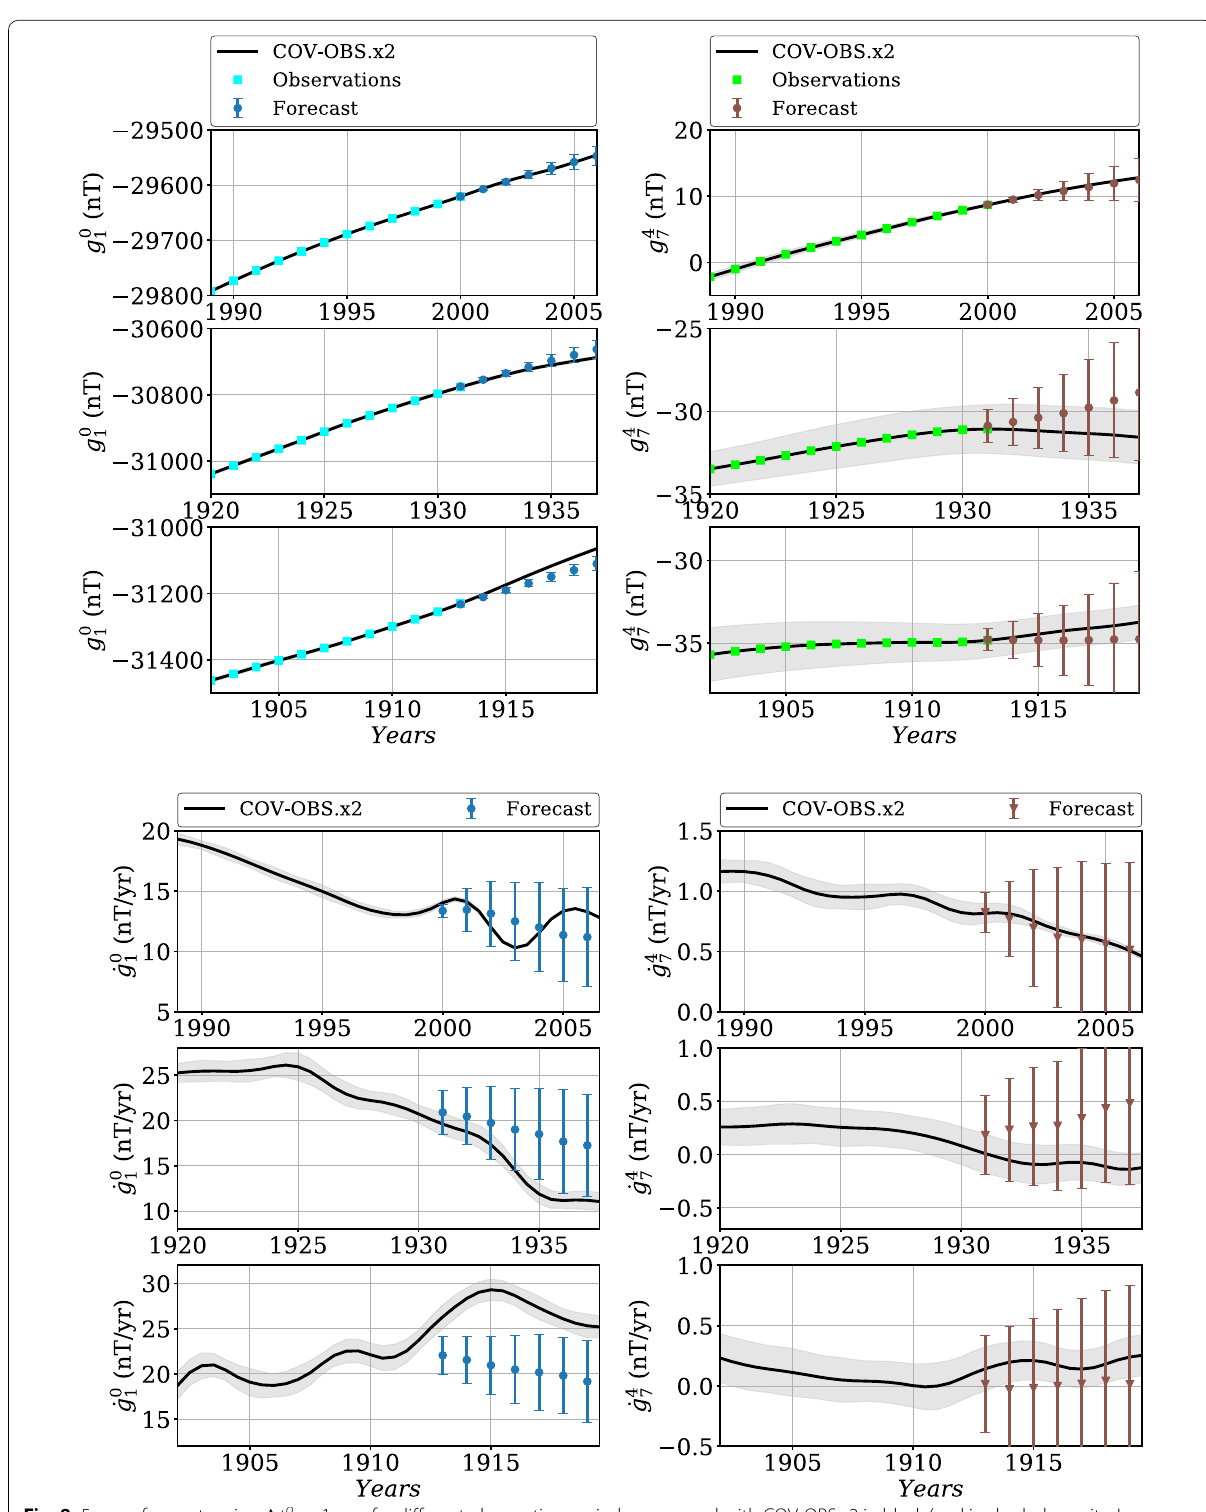
Fig. 8 5-years forecasts using (cid:31) t o = 1 year, for different observation periods, compared with COV-OBS.x2 in black (and in shaded gray its ± σ dispersion), for the MF (top panels) and the associated SV (bottom panels) of Gauss coefficients g 0 1 (left) and g 4 7 (right). Errorbars represent the dispersion ( ± σ ) within the ensemble of